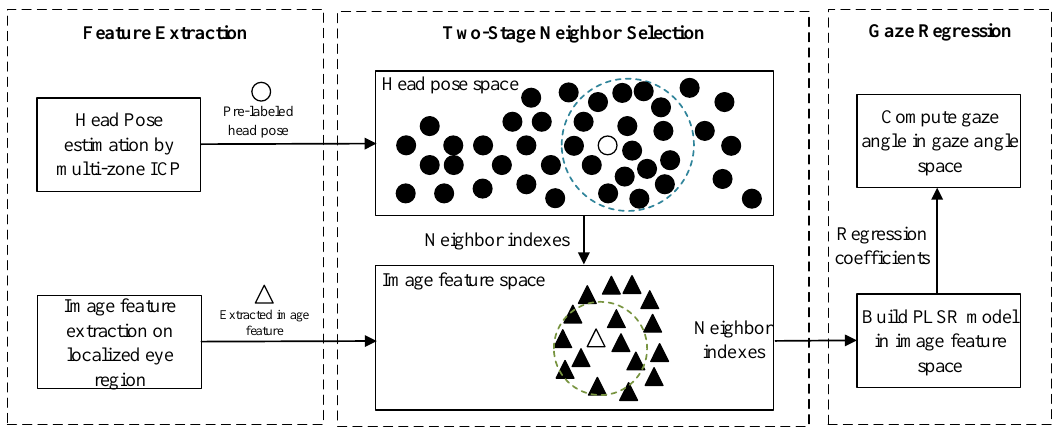
Figure 7. Appearance-based gaze estimation using neighbor